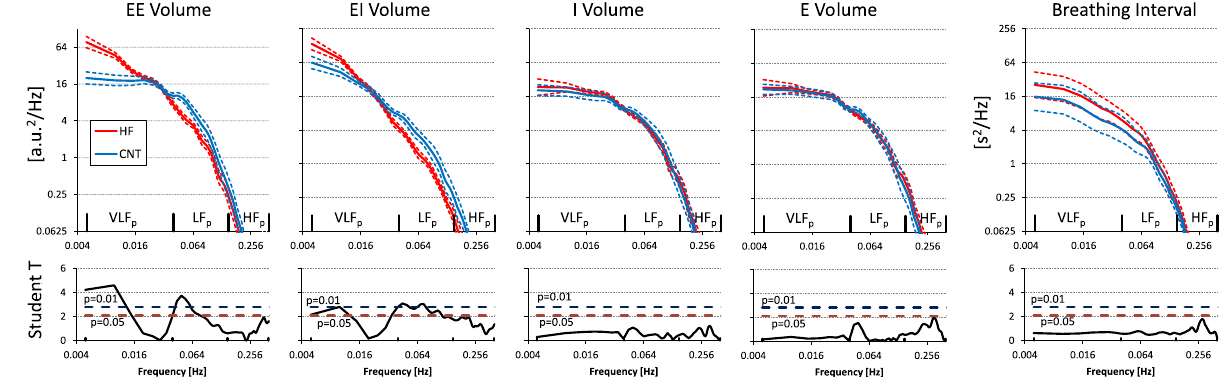
Figure 3. Power spectra of breath-by-breath respiratory series during free breathing. Geometric mean ± geometric sem in HF patients and controls (CNT). The panels below each spectrum show the Student T statistics between groups at each frequency: the horizontal dashed lines are the 0.05 and 0.01 significance thresholds. From left to right: spectra of end-expiratory (EE), end-inspiratory (EI), inspiratory (I), and expiratory (E) volumes, and of breathing